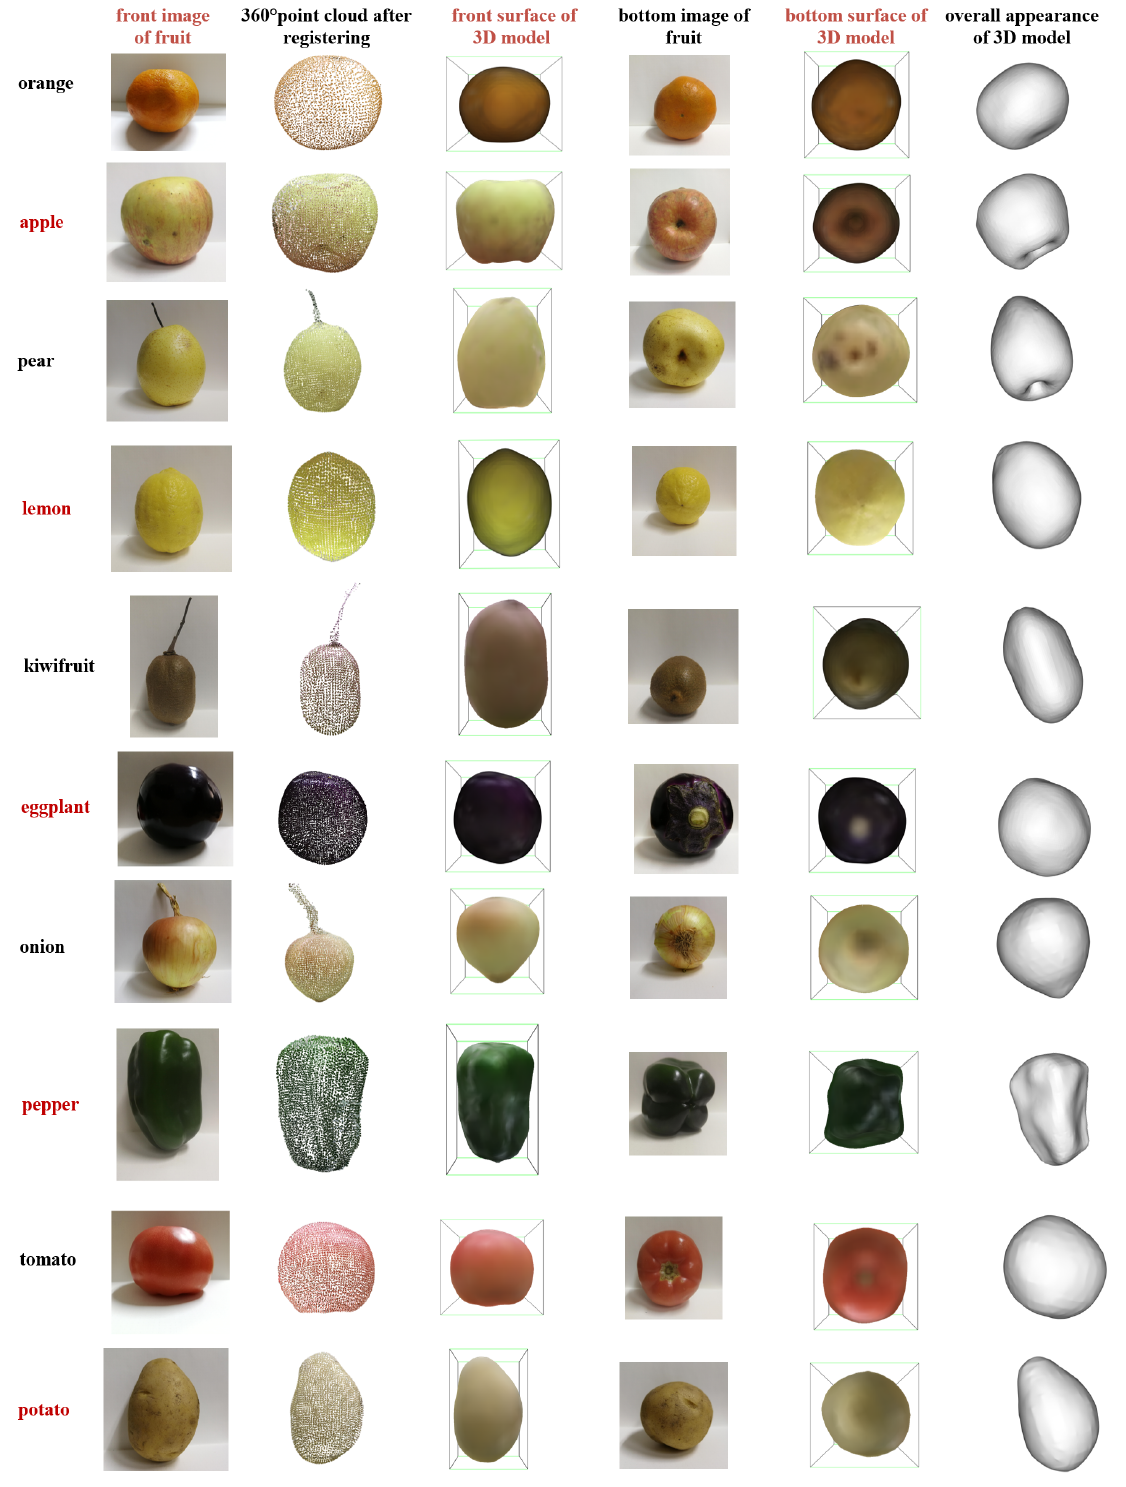
Figure A1. Description of many kinds of fruit models with real images from different